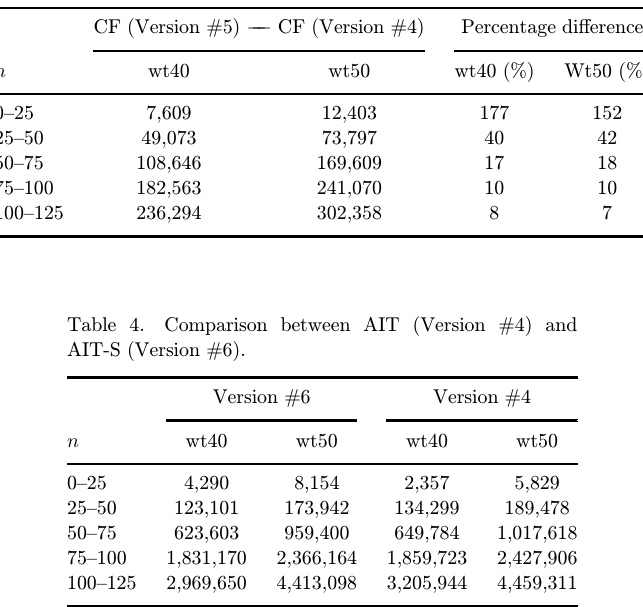
Table 3. AIT Version #4 and Version #5 percentage comparison.